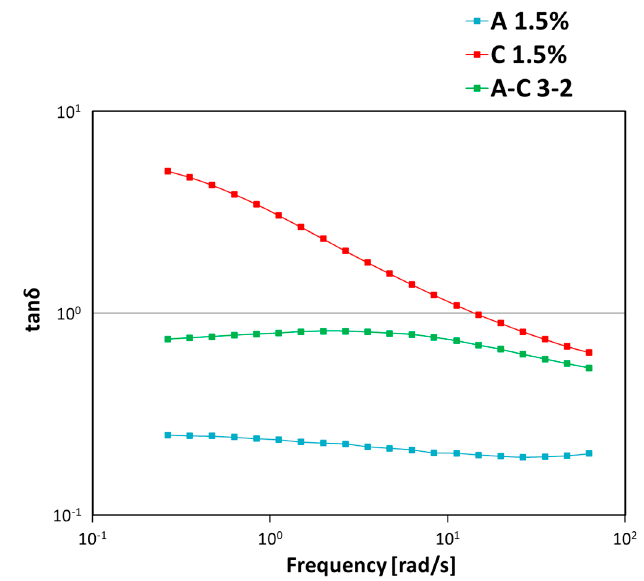
Figure 7. Damping factor tan δ trends as a function of the frequency for the samples prepared with A, C, and the A–C association (ratio 3:2) at 1.5% w/w of the total polysaccharide amount.